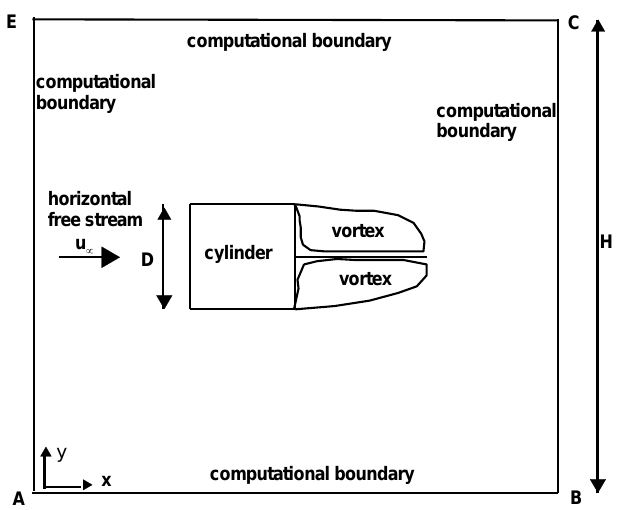
Figure 1. The flow configuration and coordinate system.